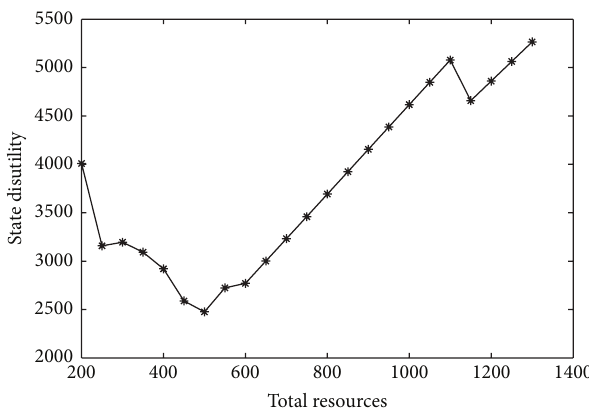
Figure 5: The relationship between total resources and state disutil- ity when 𝑚 = 6